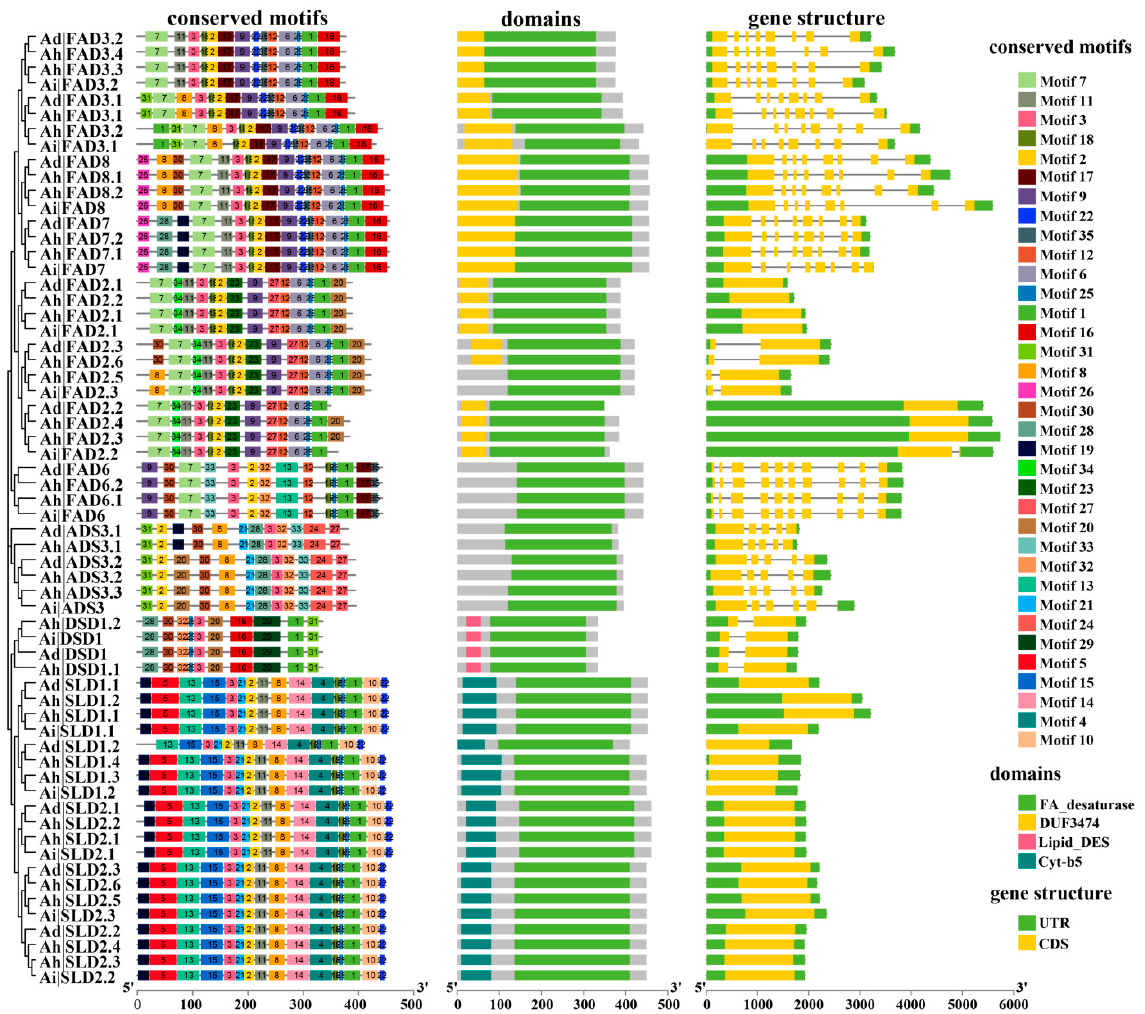
Figure 2. Gene structure of FAD genes and conserved motifs and domains of their encoding proteins in three peanut species.